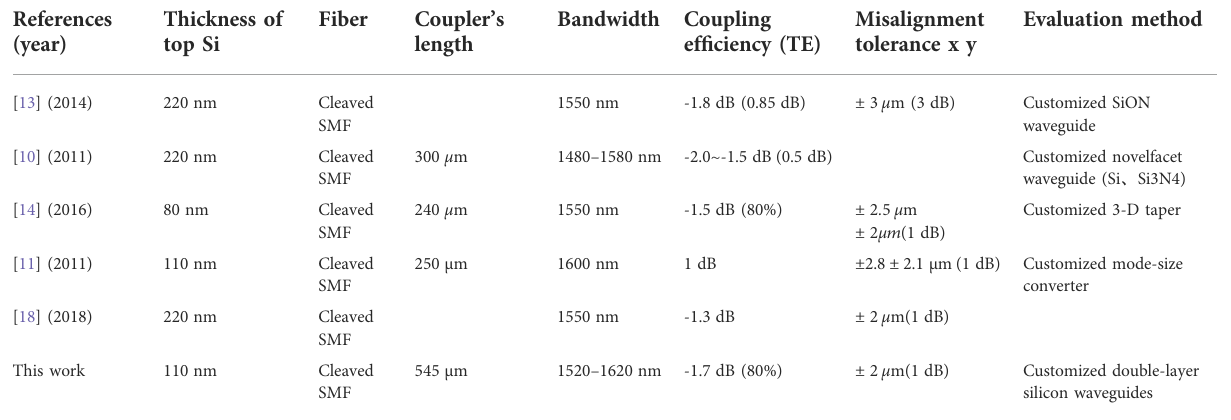
TABLE 2 Comparison of different edge